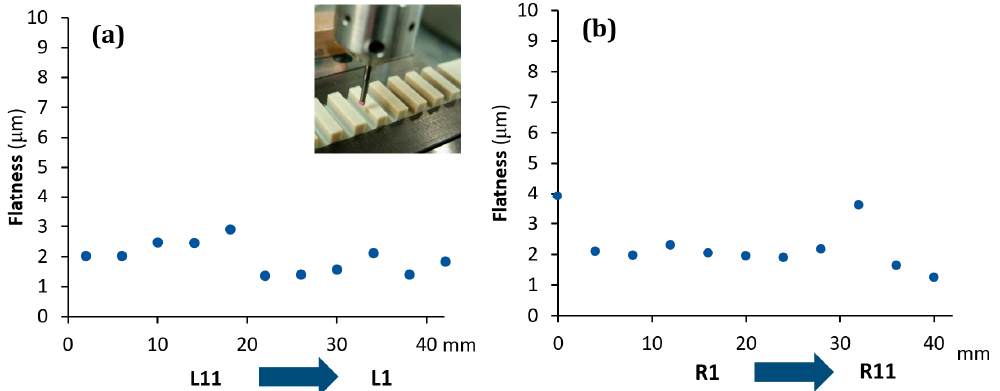
Figure 10. Flatness evaluated with the CMM. Left groove sides ( a ) and right groove sides ( b ).